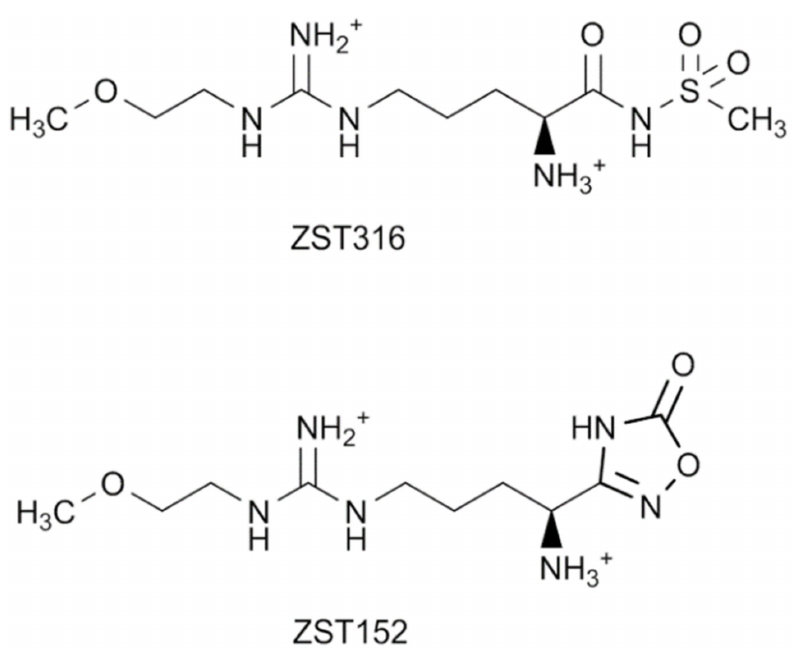
Figure 1. Chemical structures of the DDAH1 inhibitors ZST316 and